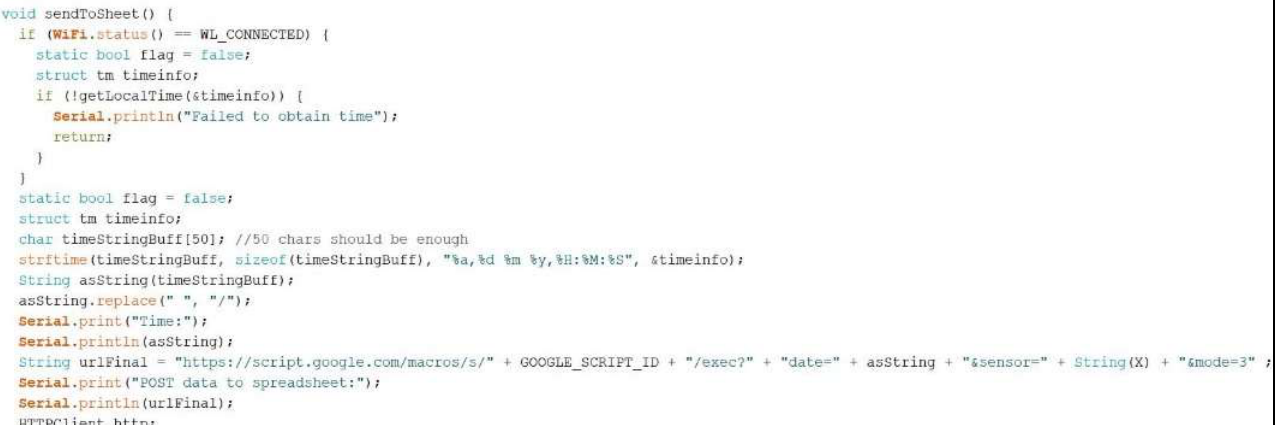
Figure 9 . Code 8 — electrostimulation parameterization.